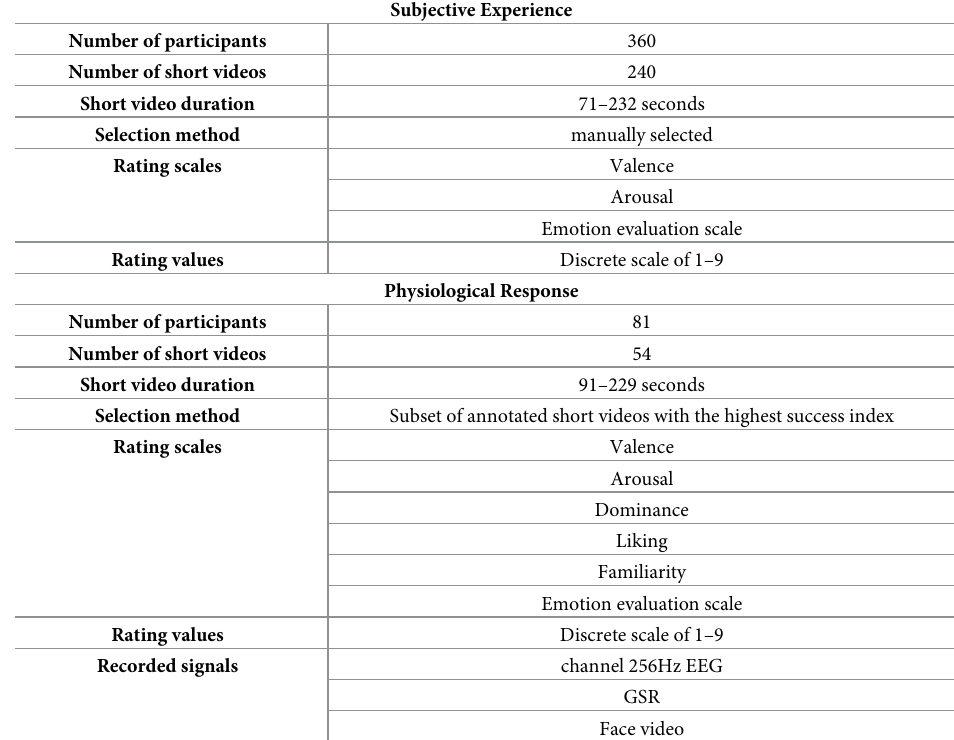
Table 6. Summary of the database